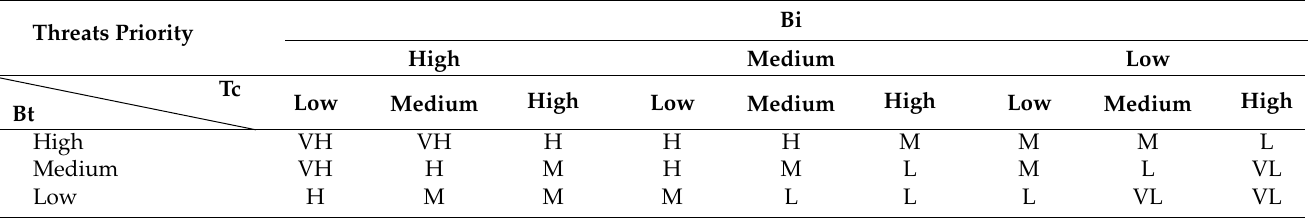
Table 4. Table represents the Matrix of threat